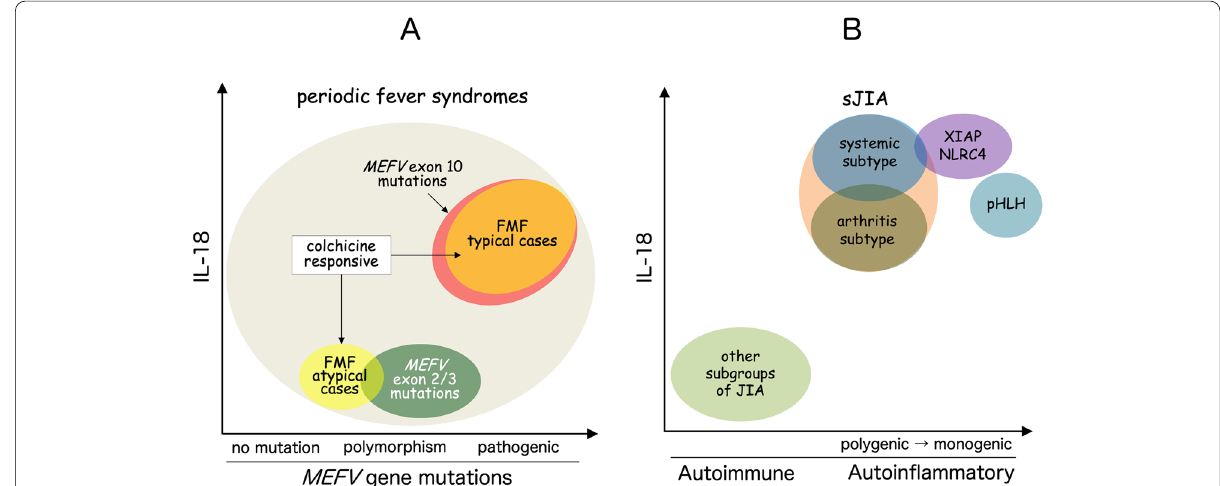
Fig. 7 Schematic view of FMF and diseases with high serum IL-18. Schematic views of FMF and periodic fever syndromes ( A ) and sJIA/AOSD and related diseases ( B ) are shown. Typical cases of FMF (orange) consist of cases with characteristic clinical presentation, colchicine response, high serum IL-18, and pathogenic mutations within exon 10 of MEFV (red). Some cases of periodic fever syndromes may also respond to colchicine without exon 10 mutation of MEFV (yellow). These cases, with (dark green) or without mutations (ivory) of MEFV , are classified as atypical FMF. Other than FMF, sJIA, AOSD (blue), and several monogenic diseases, such as XIAP, NLRC4 (violet), and pHLH (navy) are characterized by extremely elevated serum IL-18 and they are prone to develop